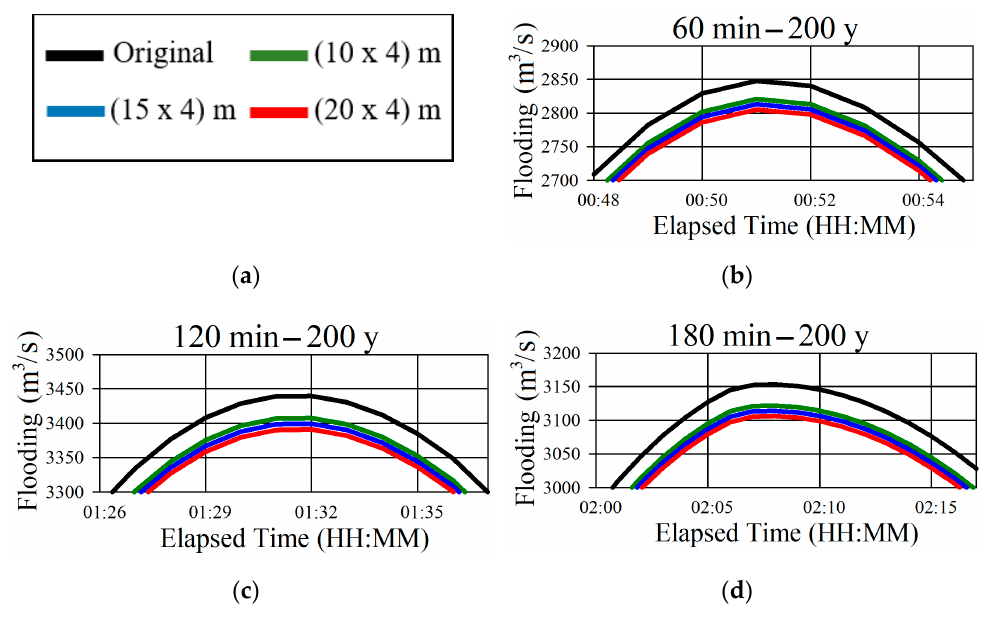
Figure 10. Flood reduction in the Suyeong River for various sizes of floodgate (rainfall quantile).